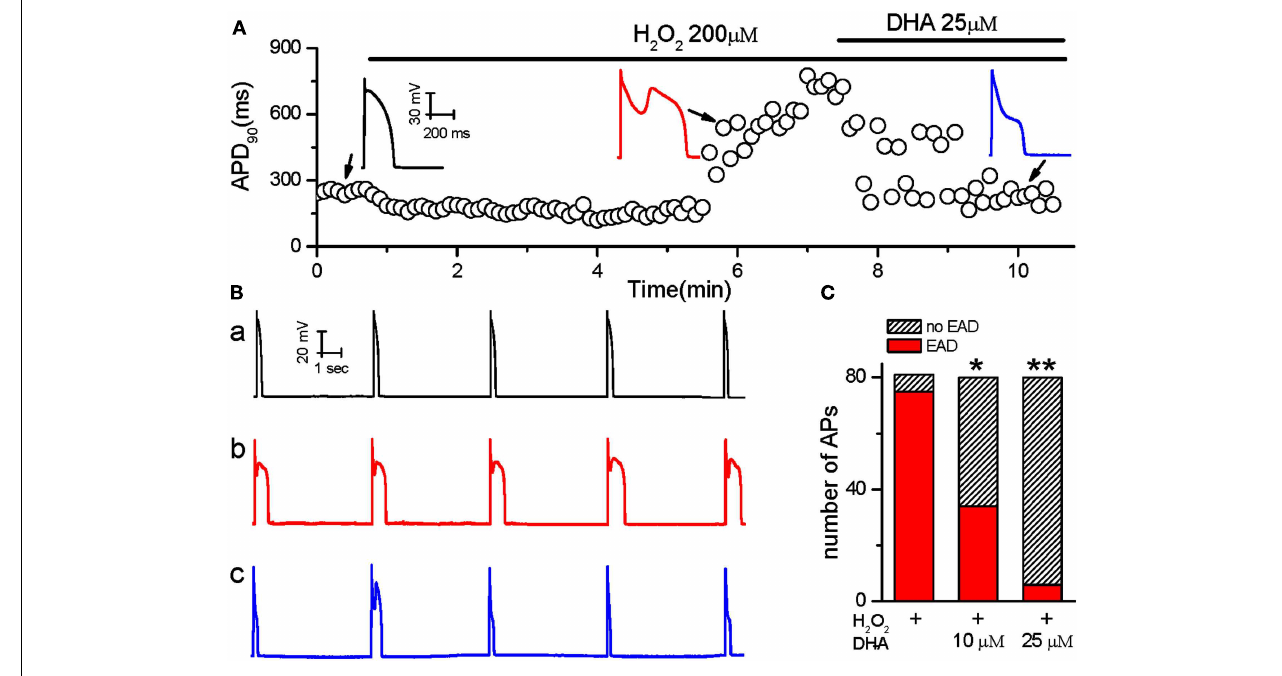
consecutive AP recordings from a cell exposed to control perfusate (a) , 200 µ M H 2 O 2 (b) and 200 µ M H 2 O 2 + 25 µ M DHA (c) . (C) Summarized bar graph showing dose-dependent inhibitory effects of DHA on the incidence of EADs induced by H 2 O 2 ( n = 8 cells). * p < 0.05, ** p < 0.01; Fisher’s ExactTest vs. H 2 O 2